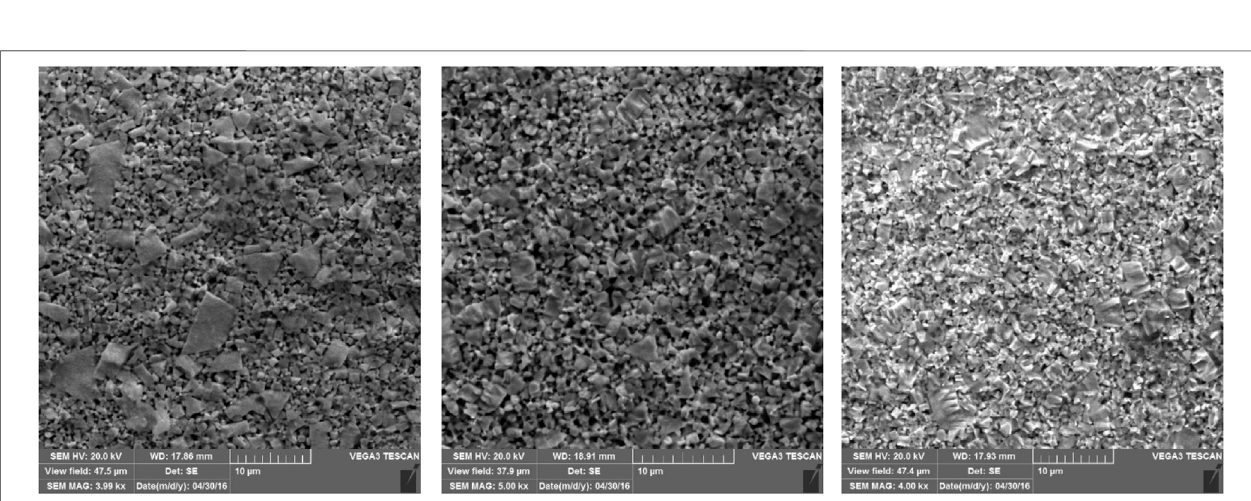
FIGURE 2 | The morphology of three different